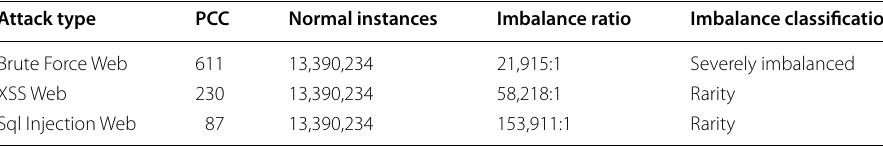
PCC Positive Class